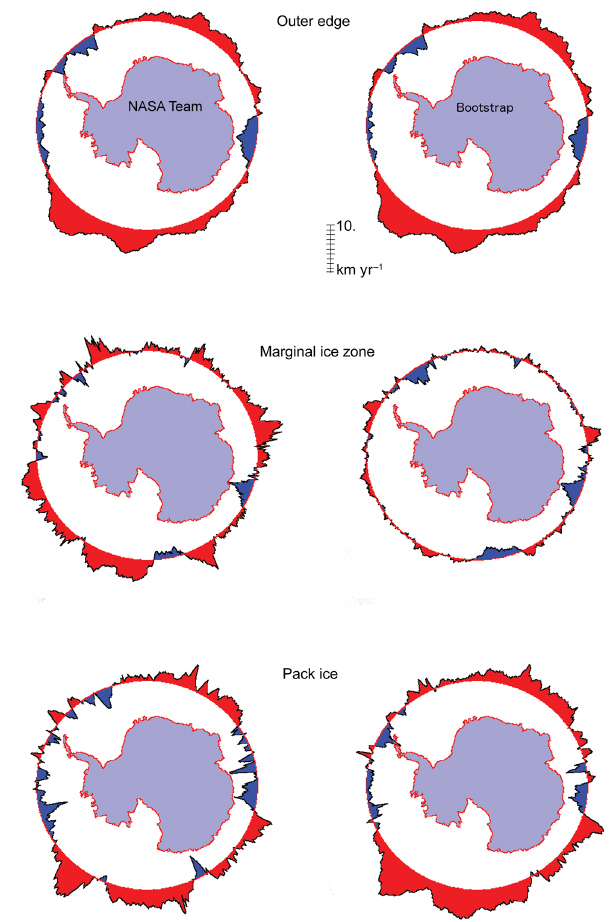
Figure 7. Expansion (red) or contraction (blue) of the outer ice edge (top), the width of the marginal ice zone (middle) and the width of the pack ice from 1979 to 2013 during the month of